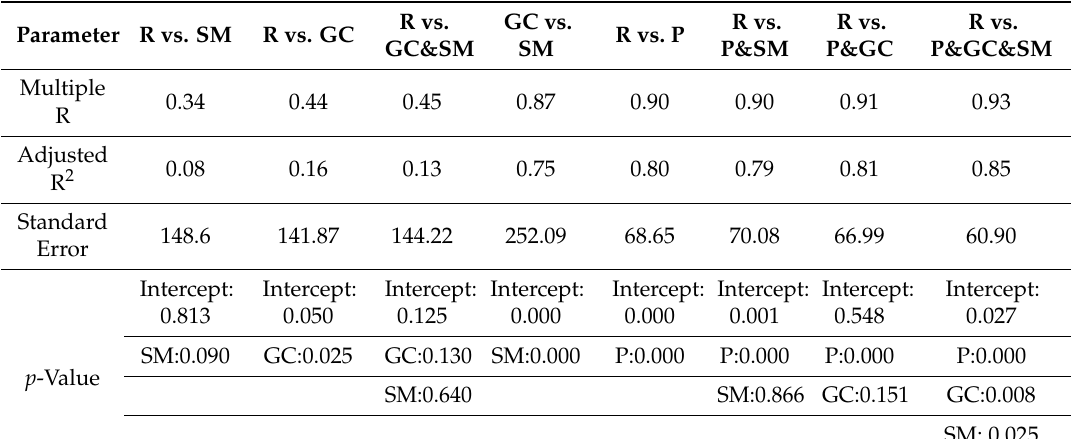
Table 2. Statistical parameters of multilinear regression analysis of runoff (R) vs. rainfall (P), ground cover (GC) and soil moisture (SM). Correlation increases from left to right. Sample size is 26. Parameter R vs. SM R vs. GC